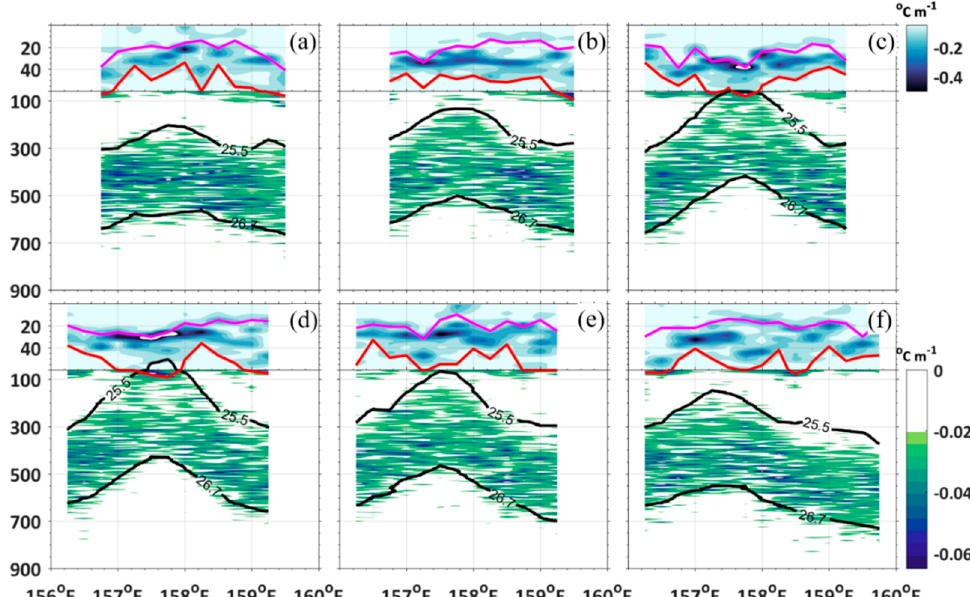
Figure 7. Thermocline. ( a ), ( b ), ( c ), ( d ), ( e ) and ( f ) are for the sections of S1, S2, S3, S4, S5 and S6, respectively. The vertical gradient of temperature ( T z ) is used to identify the thermocline. T z larger than 0.05 °C/m and 0.02 °C/m are deemed to be the seasonal thermocline and permanent thermocline. The magenta and red lines denote the upper and lower boundaries of the seasonal thermocline. The magenta line also shows the MLD. The black lines are the isopycnals of 25.5 and 26.7 σ θ , which correspond to the upper and lower boundaries of the permanent thermocline. The criterion of 𝑇 (cid:3053) (cid:3410) 0.02 ℃/m is adopted to identify the permanent thermocline.